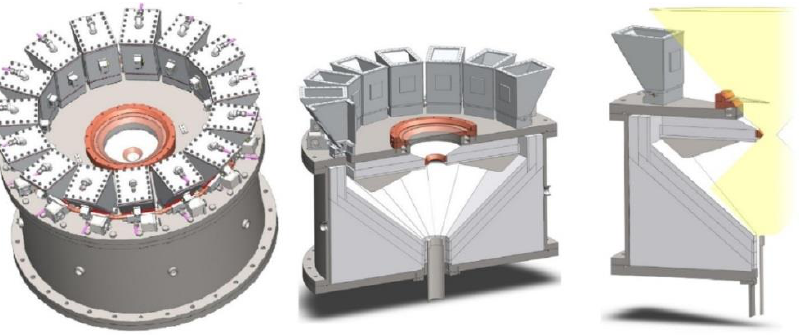
Figure 12. Scheme of the solar reactor with gravity-driven particles injection.